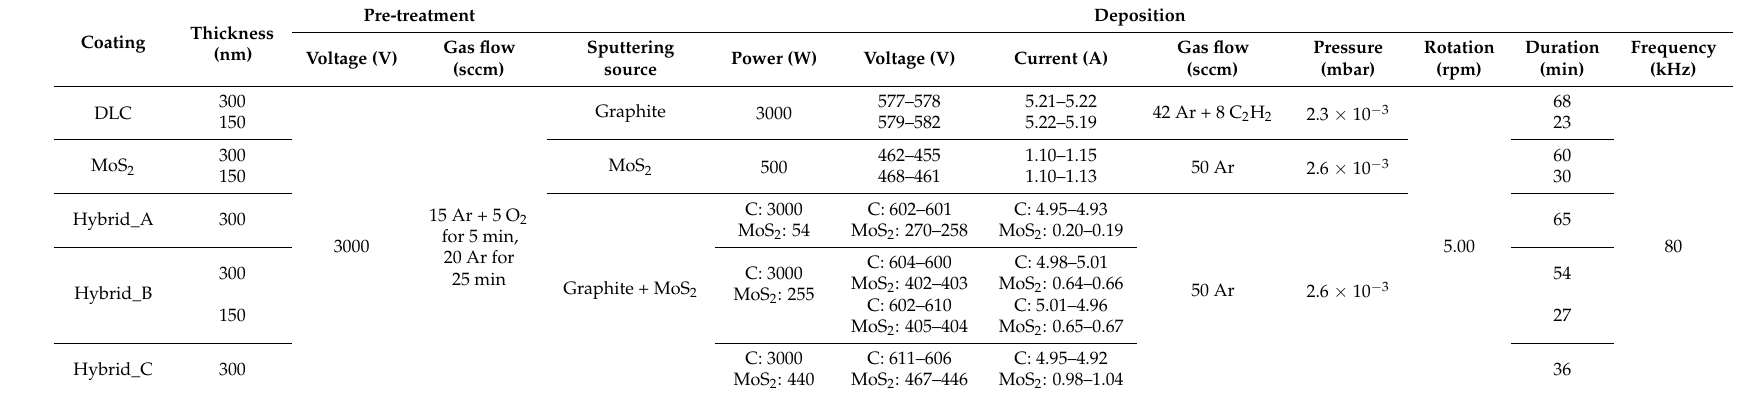
Table 1. Parameters of pre-treatment and deposition process.